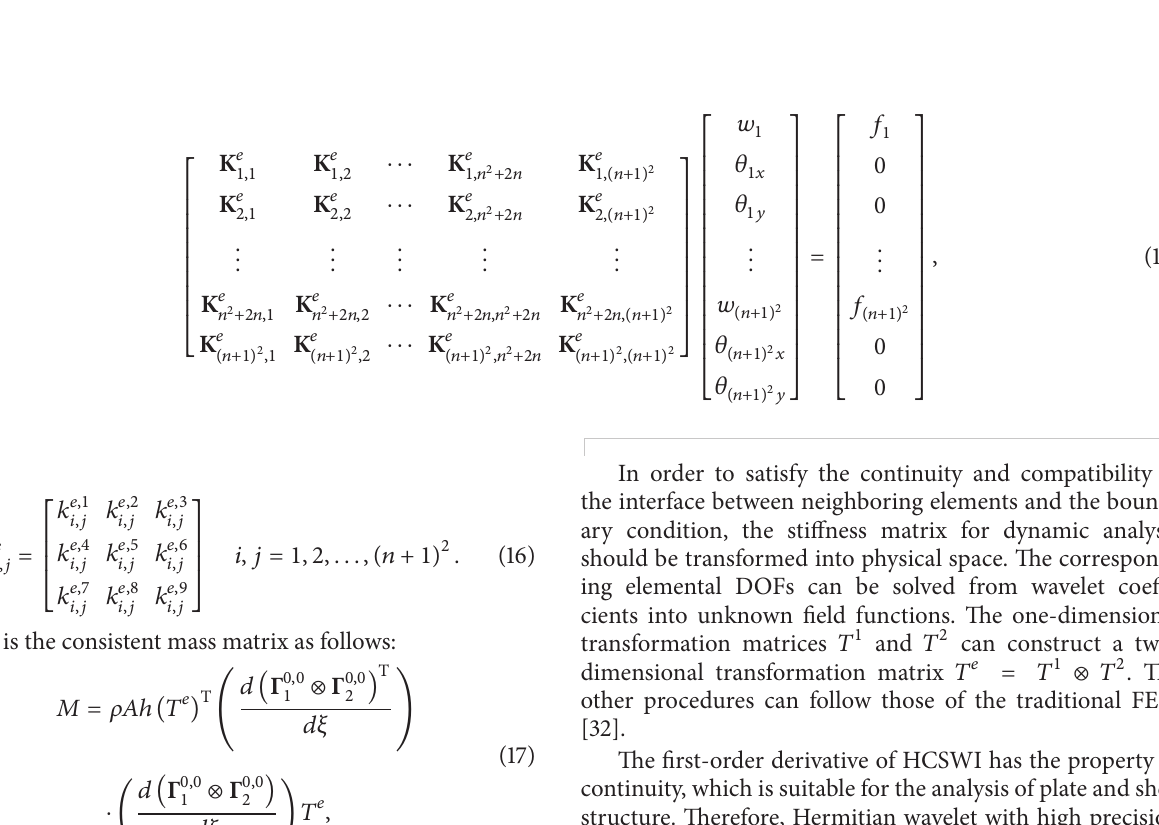
Figure 7: The location of 𝑓 in the Mindlin